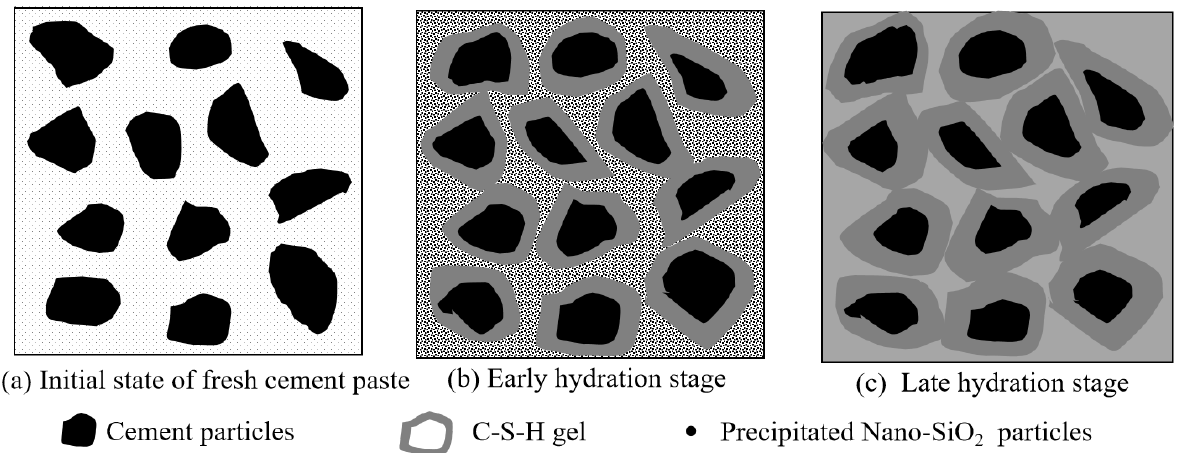
Figure 7. The reaction mechanism of initial state, early hydration stage and late hydration stage of PS-CBM.